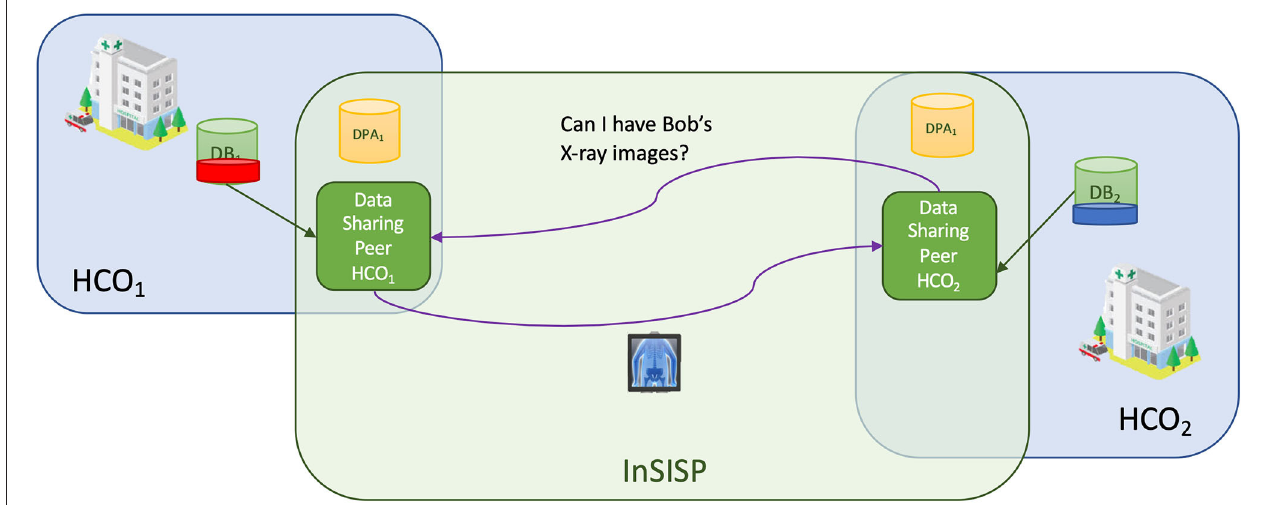
FIGURE 7 | Overview of the peer to peer with message exchange design.